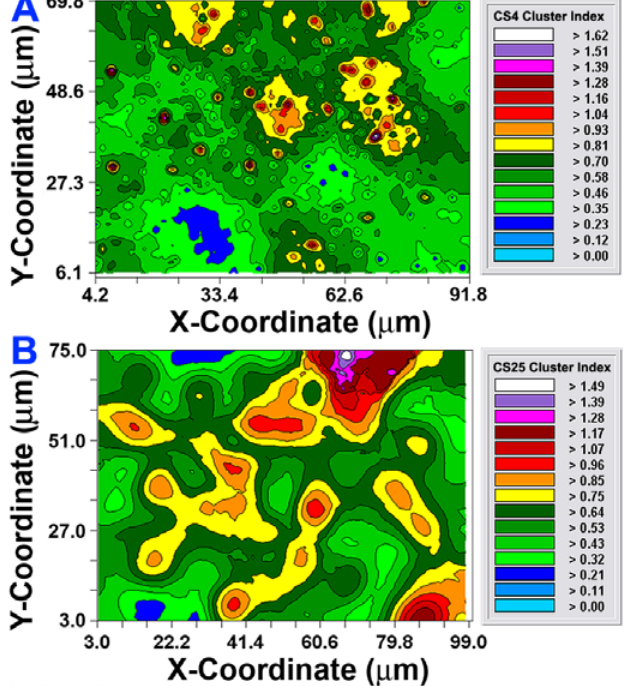
Figure 6. 2-dimensional Kriging maps of the spatially autocorrelated local cluster indices for the microbes within the CS4 ( A ) and CS25 ( B ) biofilm samples. Note the significantly greater patch size and interpolation of higher intensity of clustered patterns in the CS25 biofilm ( B